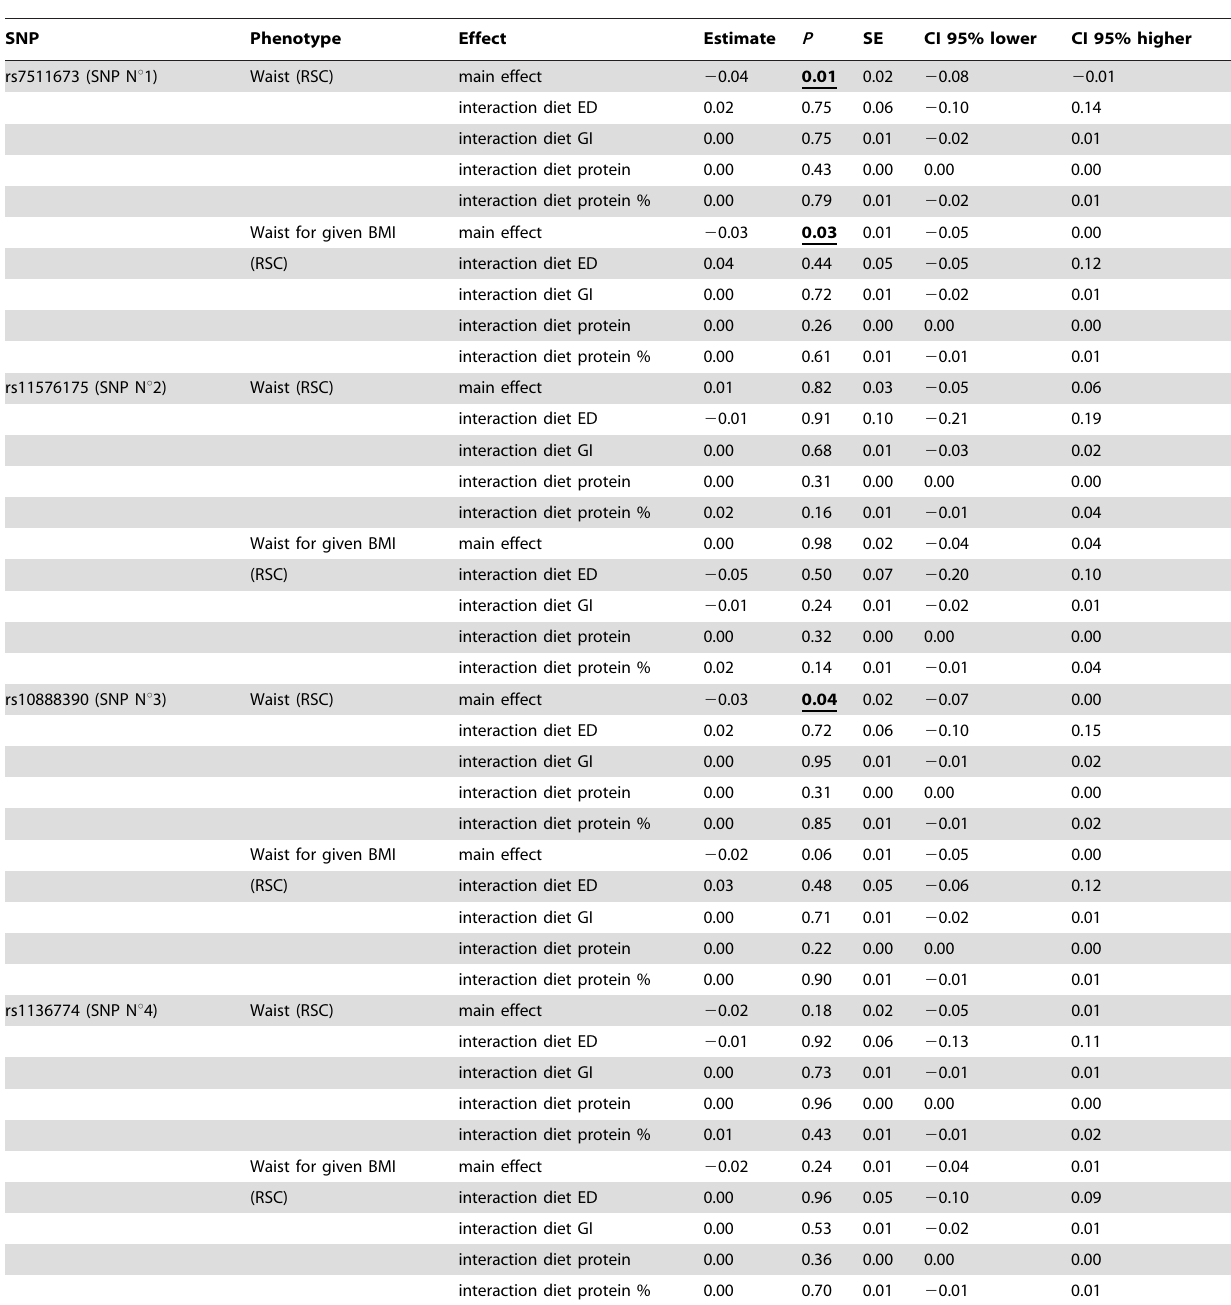
Table 5. Association between CTSS SNPs and body fat distribution change during the study.